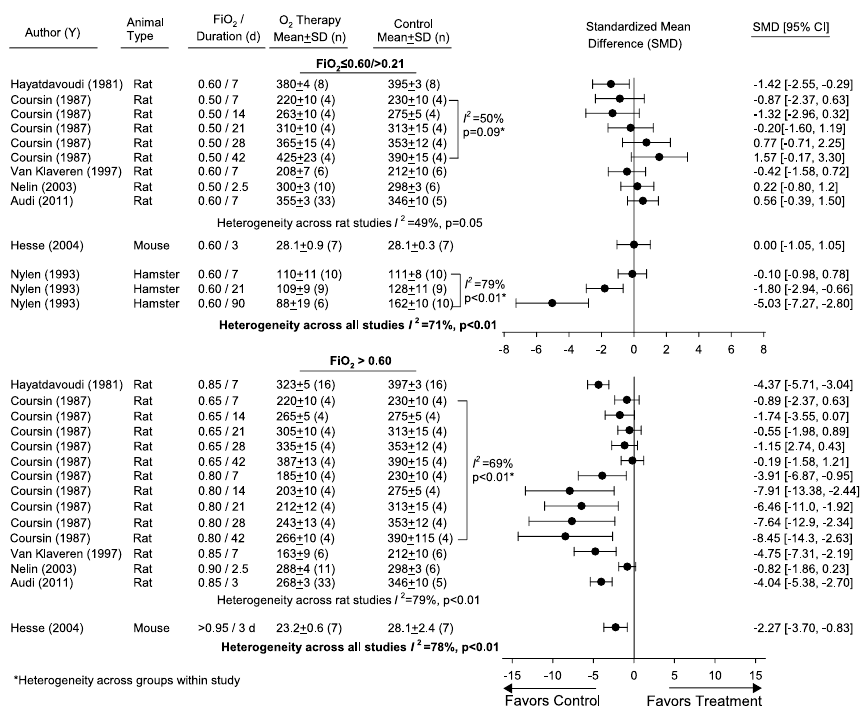
Fig. 4 Effects of FiO 2 s 0.60 and > O.21 (FiO 2 0.60/ > O.21) (upper panel) or FiO 2 > 0.60 (lower panel) vs. ≤ ≤ FiO 2 s 0.21 (controls) on standardized mean differences ( SD) (SMD) in body weights in grams in studies = ± [author (y)] that did not include an infectious or noninfectious inflammatory challenge. Animal type, increased FiO 2 level, and duration employed in studies or groups are shown. Also shown for each study or group are the standardized means ( SD) and numbers of animals ( n ) used to calculate individual SMDs. ± Data from studies used to calculate SMDs for these parameters and parameter units are shown in Additional file 1: Table S6. Analysis for two studies (Coursin and Nylen) that included more than one regimen of FiO 2 0.60/ > O.21 or FiO 2 > 0.60 showed that the levels of significance for heterogeneity ( I 2 50%, p 0.09) ≤ ≥ ≤ across these regimens prevented pooling groups and these groups are shown as solid circles and used in analysis individually here. Heterogeneity across studies and groups also prevented calculating overall SMDs for FiO 2 0.60/ > O.21 ( I 2 71%, p < 0.01) and FiO 2 > 0.60 ( I 2 78%, p < ≤ = =